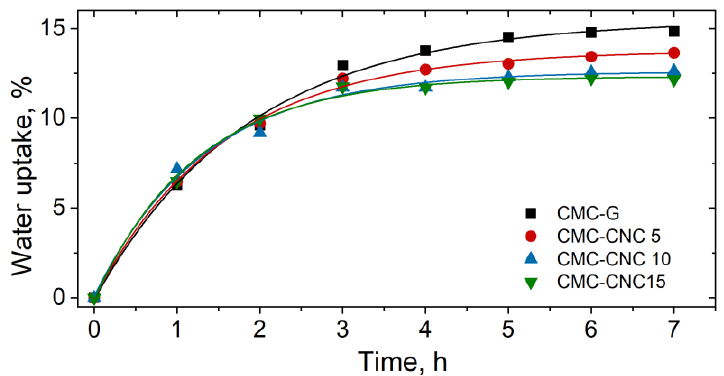
Figure 12. Water uptake recorded as a function of time for the studied samples. Materials 2020 , 13 , x FOR PEER REVIEW 14 of 16